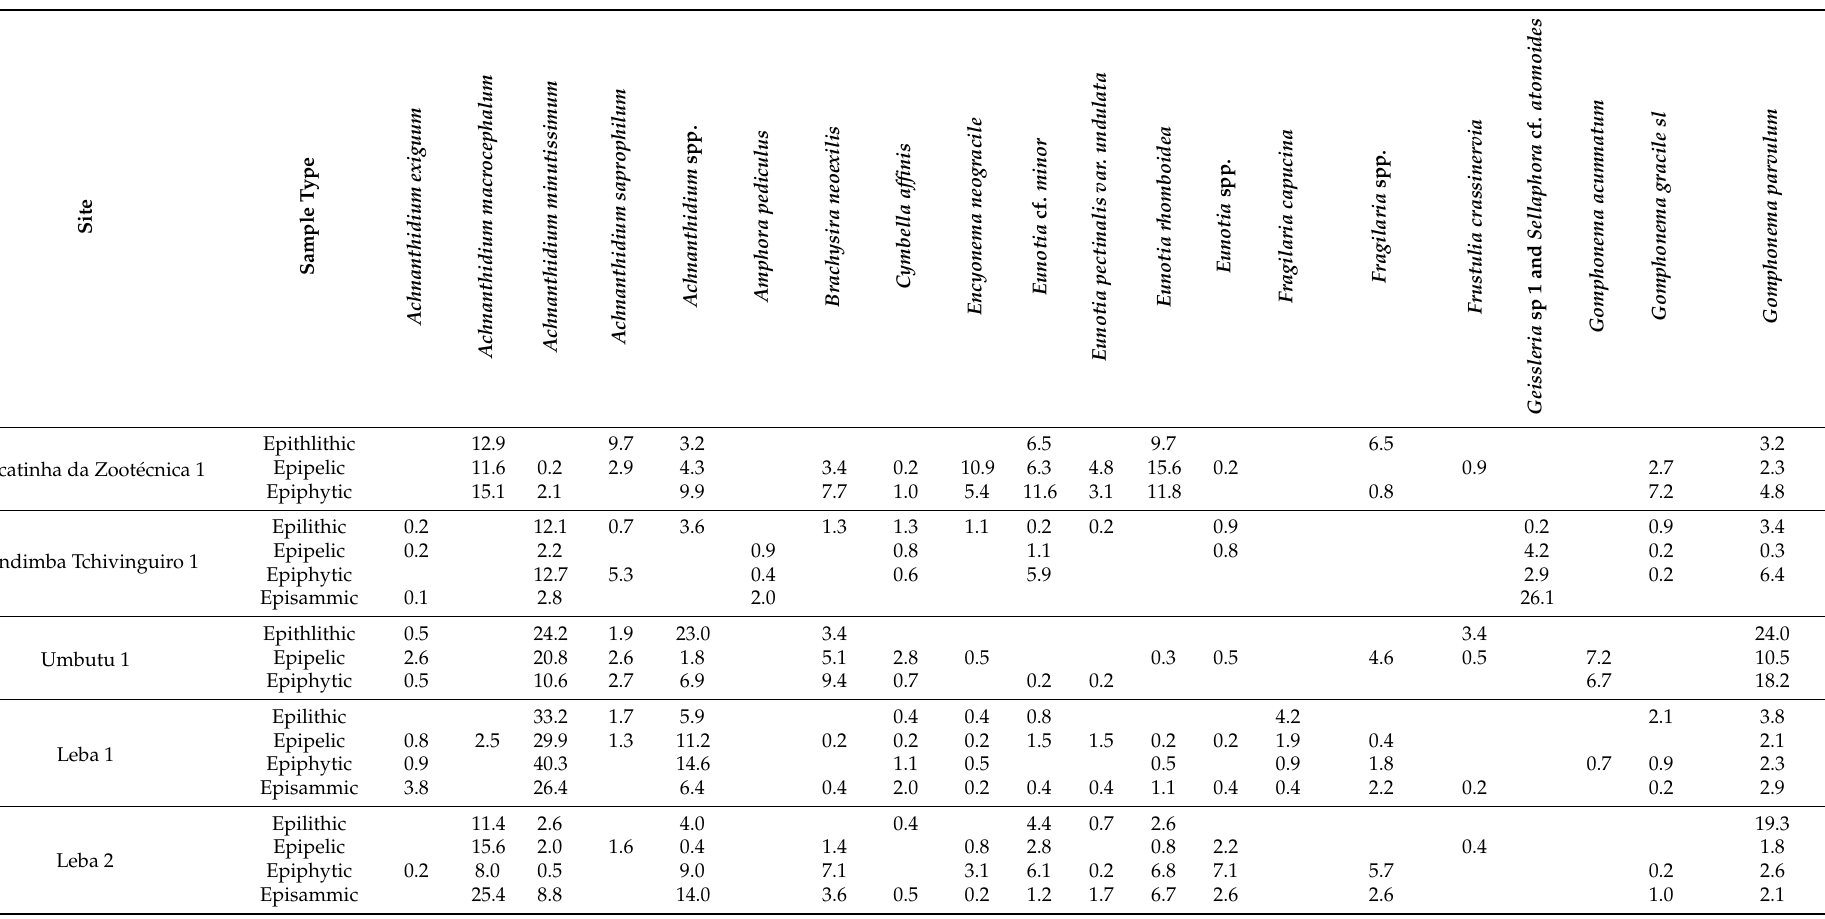
Table 2. A list of all diatom percentages in relation to the total diatoms in each community of each water body. Percentages of taxa with an abundance of at least 2% within a habitat at a water body were used. Epilithic refers to diatoms on rock, epipelic are diatoms in muds, epiphytic are diatoms on plants, and episammic are diatoms on sands. Planktonic samples did not yield enough diatoms to reach the 400-valve minimum and are therefore not included in this study. Planktonic counts can be found in Table